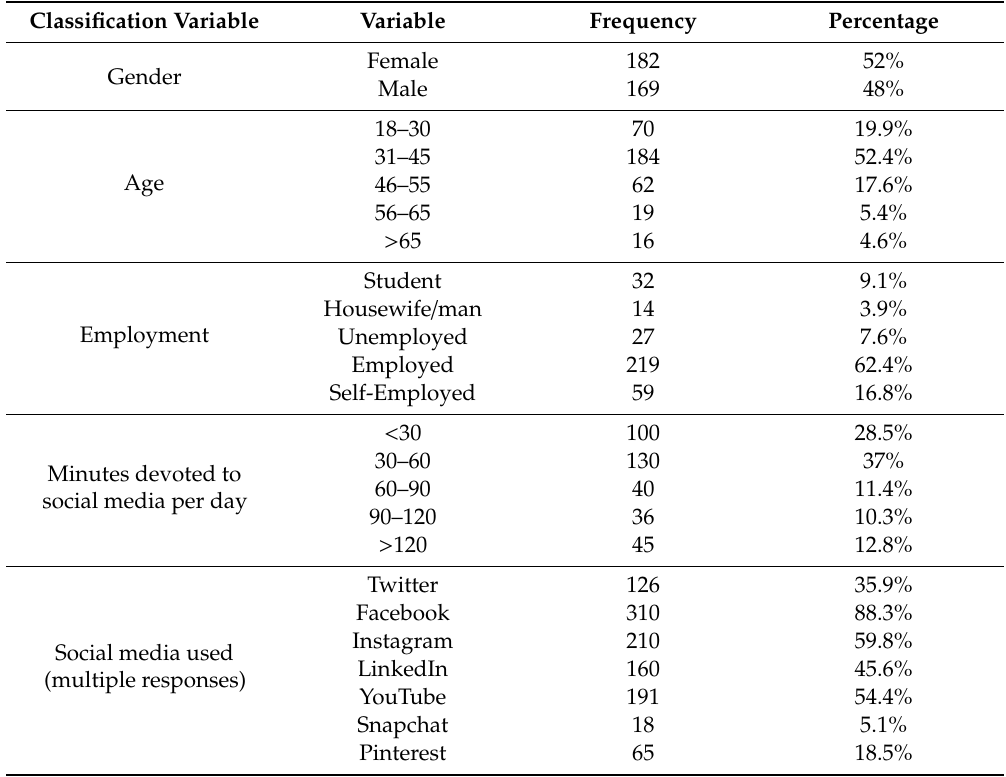
Table 1. Characteristics of the study participants ( n =